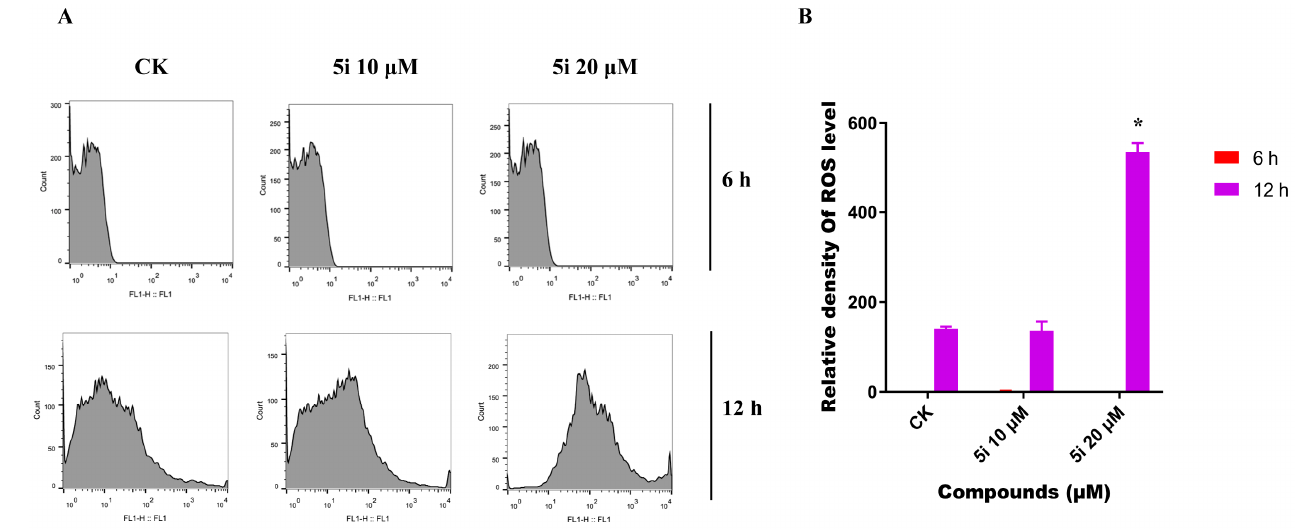
Figure 5. Compound 5i induces ROS accumulation in A549 lung cancer cells. ( A ) A549 cells were treated with 10 μ M and 20 μ M 5i at different time points (6 or 12 h) and stained with DCFH-DA (10 μ M). Intracellular ROS levels were determined by flow cytometry. ( B ) A549 cells treated with 10 μ M and 20 μ M compound 5i at different times (6 or 12 h) were quantitatively analyzed. The values are expressed as mean SD from three individual experiments. * Statistically significant ( p < 0.05).